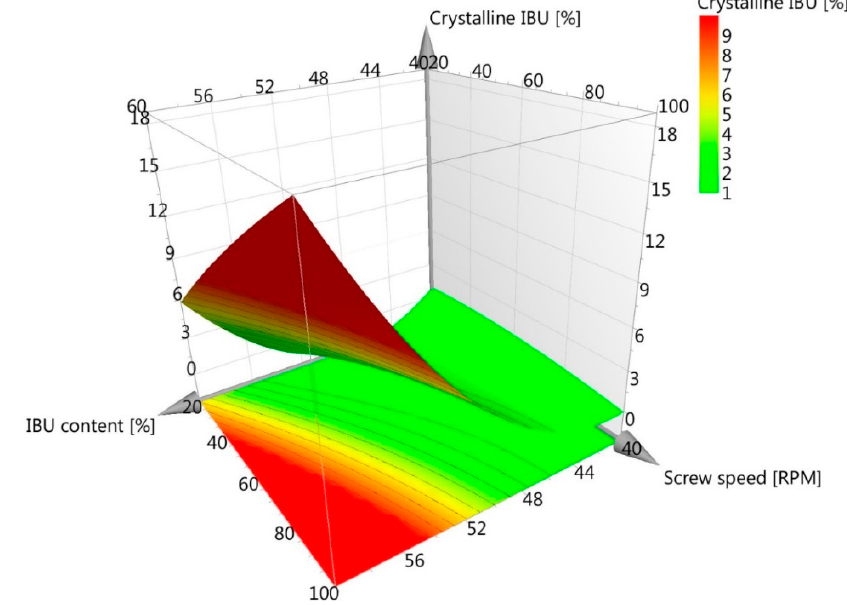
Figure 4. Surface response plot for the adjusted model.